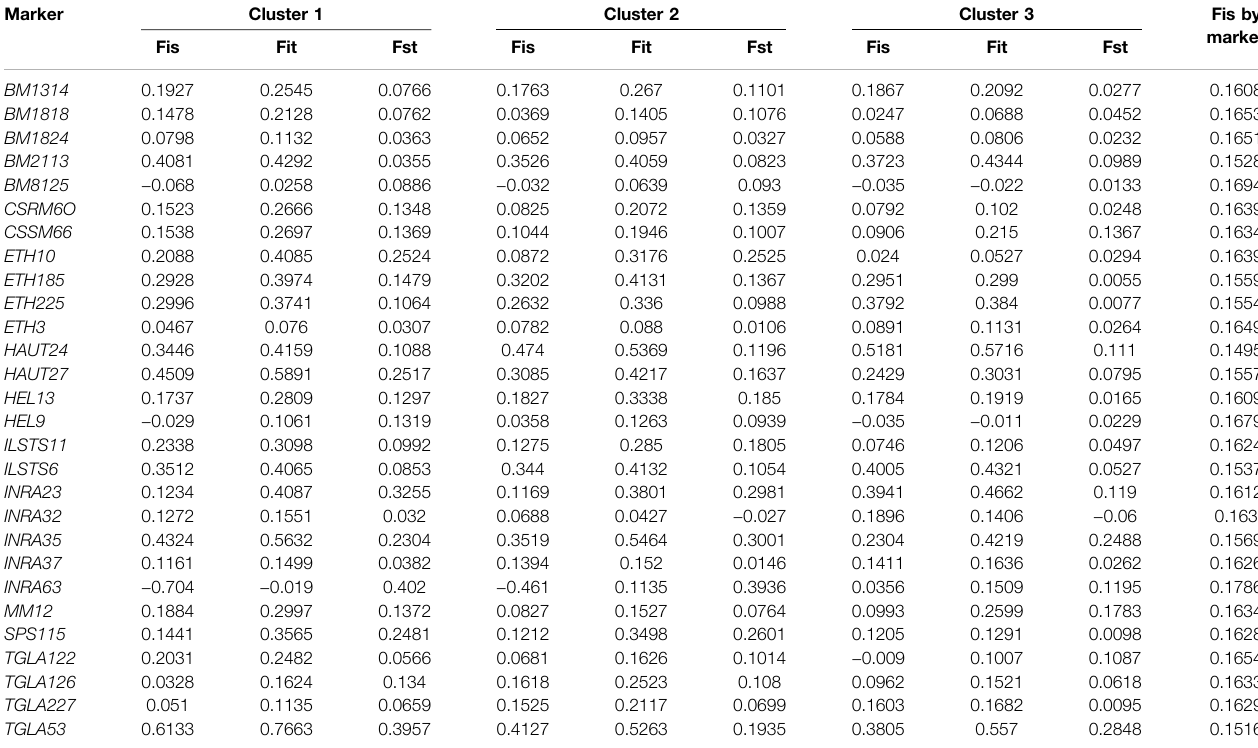
TABLE 6 | Results of F statistical analysis by phylogenetic clusters and by loci in the Curraleiro Pé-Duro cattle populations. Marker